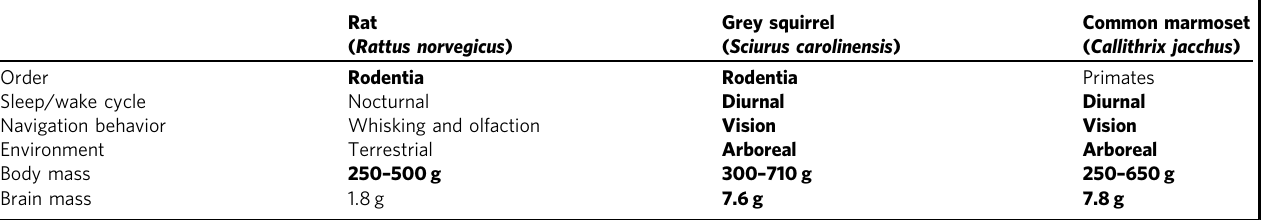
Table 1 Comparison of relevant features in each model species (similarities in bold).